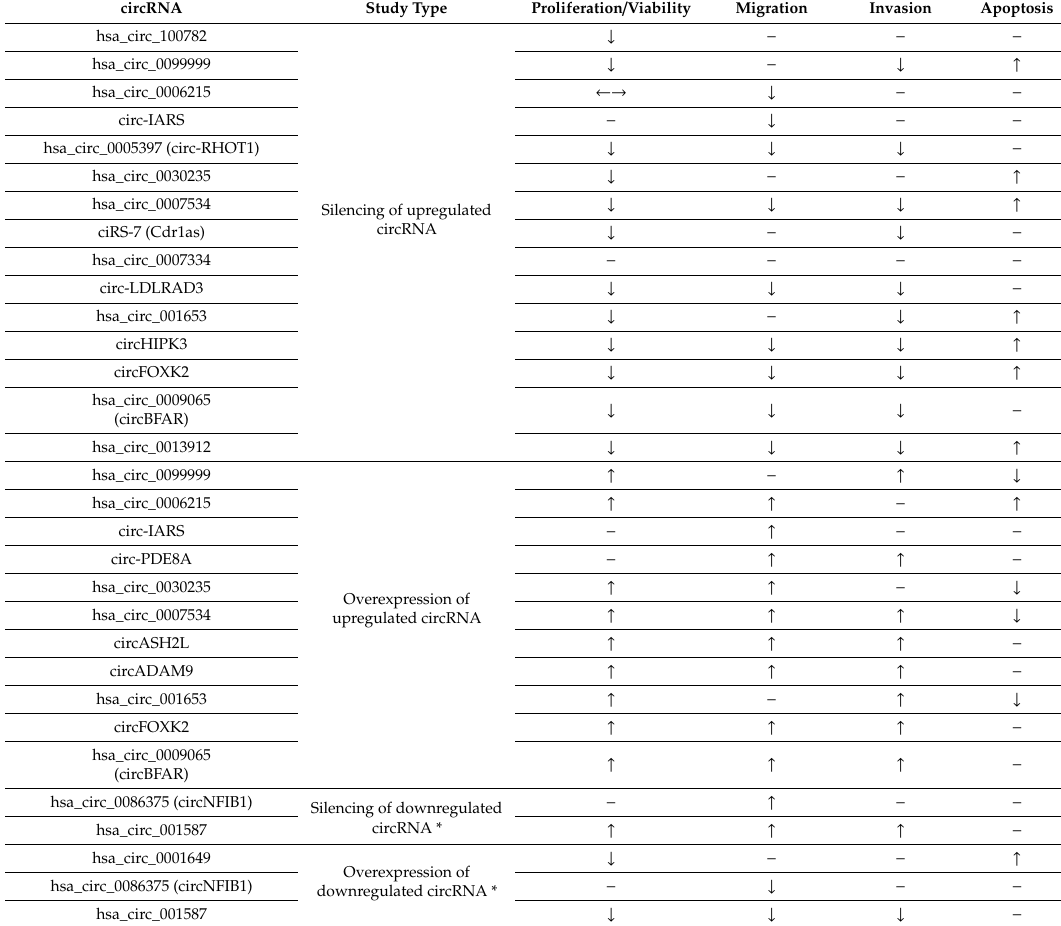
Table 3. Summary table of cellular functions of circRNAs in PDAC. * All investigated circRNAs were found to be upregulated in PDAC except hsa_circ_0001649 and hsa_circ_0086375 (circNFIB1), which were found to be downregulated. “ ↑ ” indicates an increase; “ ↓ ” indicates a decrease; “ ←→ ” indicates no significant di ff erence demonstrated; and “ − “ indicates this measure was not reported.